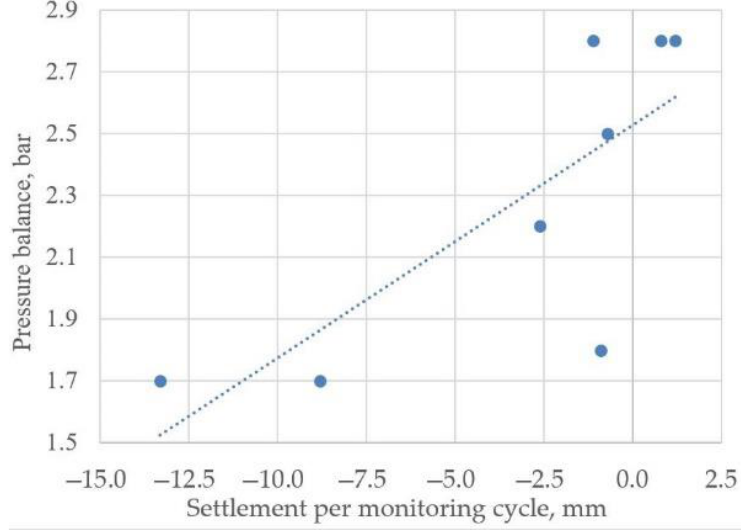
Figure 5. The dependence of the building settlement on the pressure balance during a monitoring cycle.